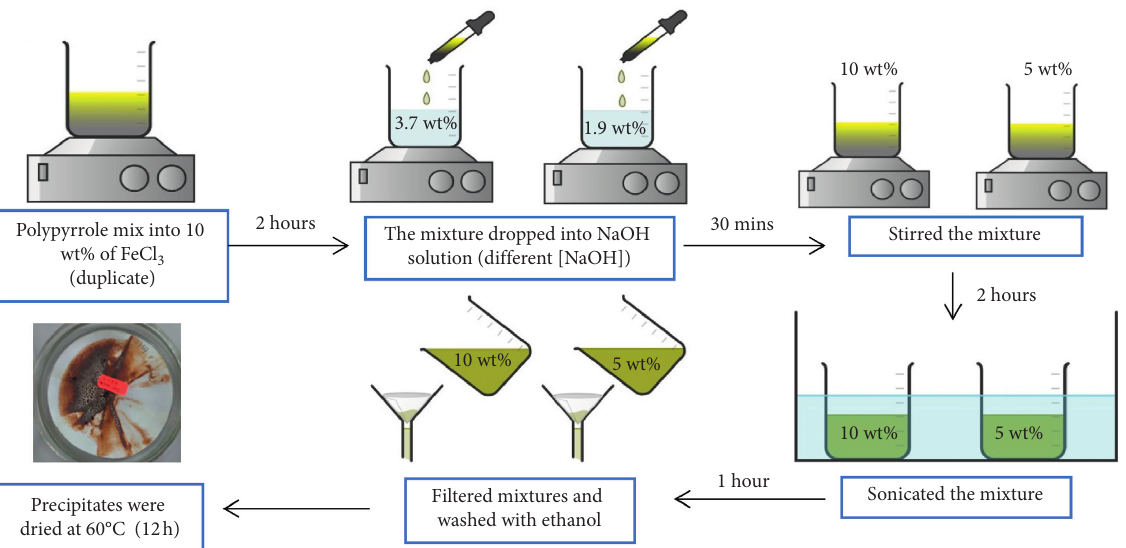
Figure 2: Schematic diagram for the preparation of PFFs